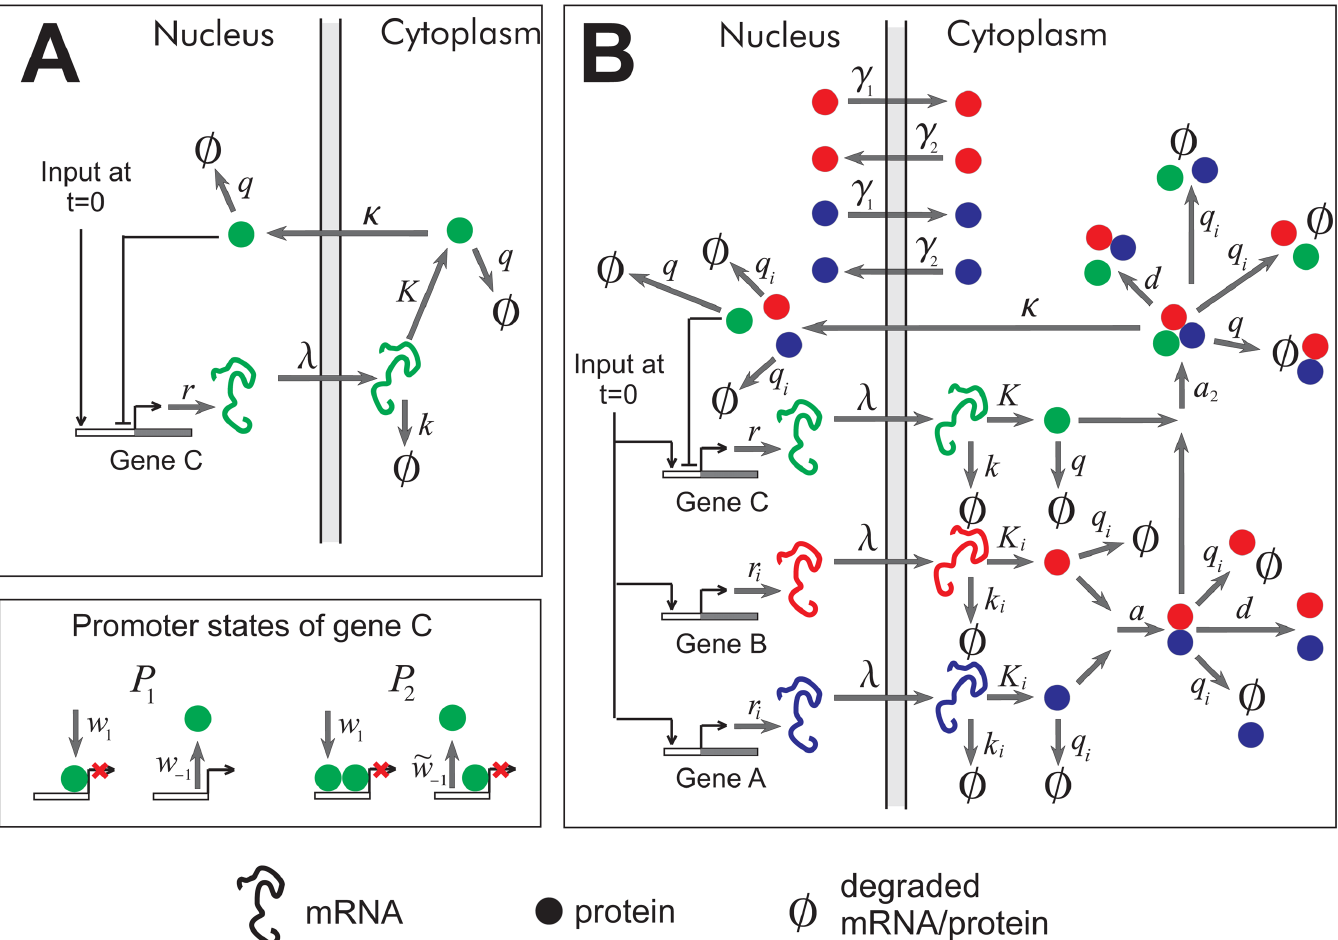
Fig 1. Two models of nuclear transport. A) Simple model: the protein of gene C diffuses freely from cytoplasm into the nucleus. B) Extended model: a gene network involving importin- α (blue), importin- β (red) and cargo protein (green). The symbol ; indicates degraded protein and mRNA. The reactions are labeled as in Eqs (3, 2, 5, 6): r — transcription rate; λ — export rate of mRNA into the cytoplasm; K — translation rate; k — rate of mRNA degradation; q — rate of protein degradation; a ( d ) — rate of association (dissociation) between importins α and β ; a 2 ( d ) — rate of association (dissociation) between the importin- α − β complex and cargo protein; κ — import rate of the importin- α − β -cargo complex; γ 1 — rate export of importins α and β into cytoplasm; w 1 ( w − 1 ) — rate of association (dissociation) between a cargo protein and a free promoter of gene C; ~ w (cid:2) 1 — rate of dissociation of a cargo protein from a fully occupied promoter.